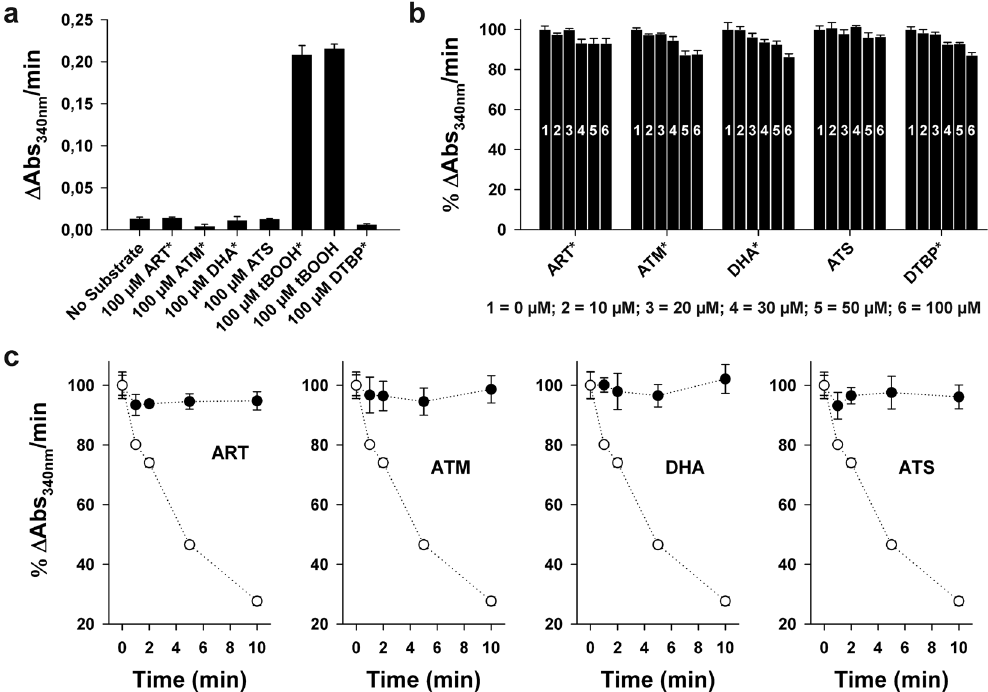
Figure 2. Peroxidase activity of recombinant Pf AOP in the presence of artemisinins. ( a ) Coupled enzymatic assays with 2.5 µ M Pf AOP and artemisinins as potential substrates. Activities with 100 µ M tBOOH or DTBP served as controls. ( b ) Reversible inhibition assays in the presence of variable concentrations of artemisinins or DTBP. Activities were determined with 2.5 µ M Pf AOP and 50 µ M tBOOH and normalized to the activities of controls without endoperoxide. ( c ) Time-dependent irreversible inhibition assays. Pf AOP (50 µ M) was preincubated with 100 µ M artemisinins for up to 10 min on ice before the enzyme was diluted 1:20 in a standard coupled enzymatic assay containing 100 µ M tBOOH. Activities were normalized to controls that were preincubated without peroxide. A time-dependent inactivation of Pf AOP by tBOOH served as a positive control (open circles) and was compared to a potential inactivation by artemisinins (closed circles). Assays containing DMSO are labelled with an asterisk. All data are the mean ± standard deviation of at least two independent duplicate